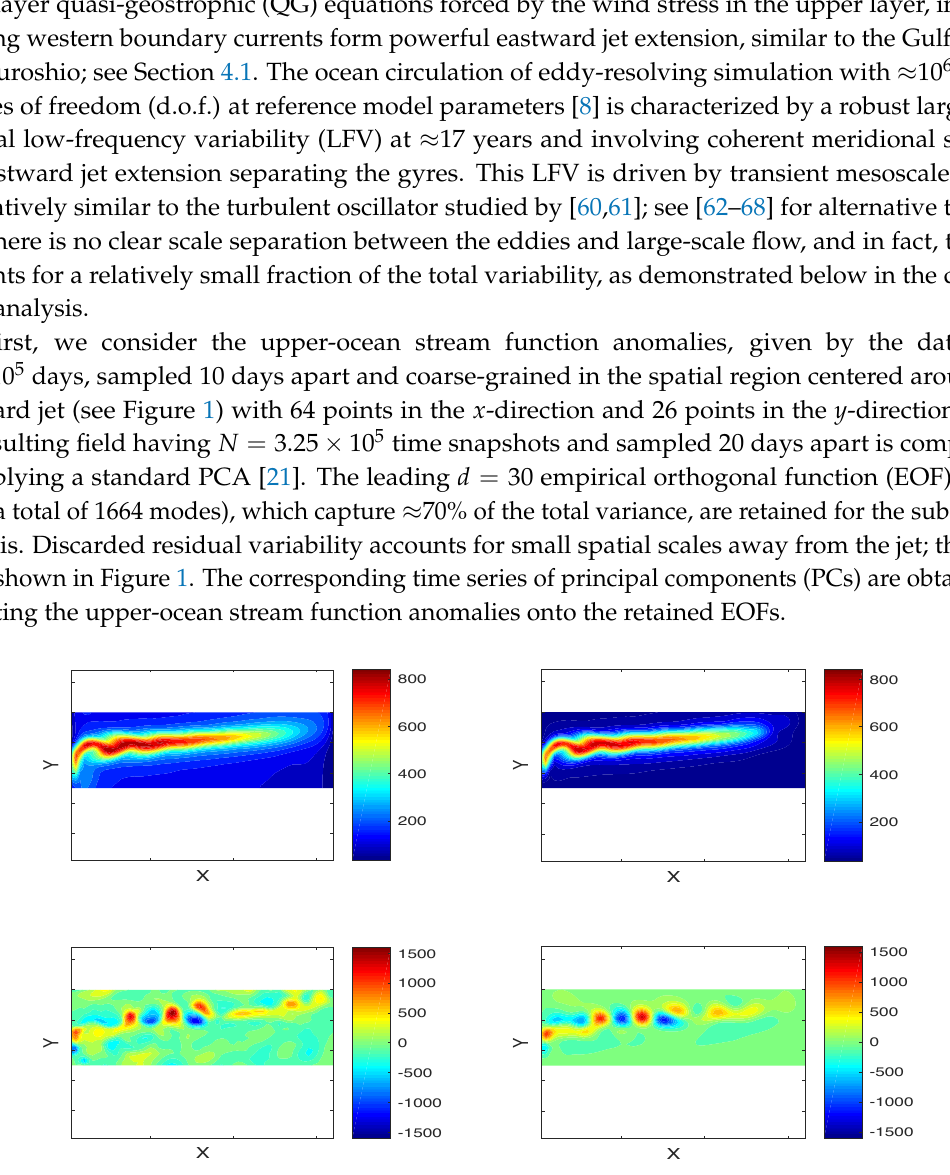
Figure 1. Upper-level stream function anomalies. (Left) Top: standard deviation; bottom: snapshot of instantaneous flow. (Right) Same, but in the truncated subspace of 30 leading spatial empirical orthogonal functions (EOFs). The nondimensional units are arbitrary, but are the same for all